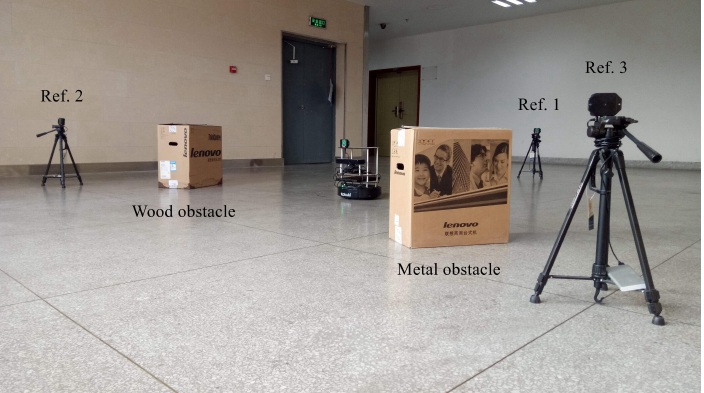
Figure 6. Mobile robot tracking experiment setup. The cartons were used as containers for wood and metal obstacles for the convenience of